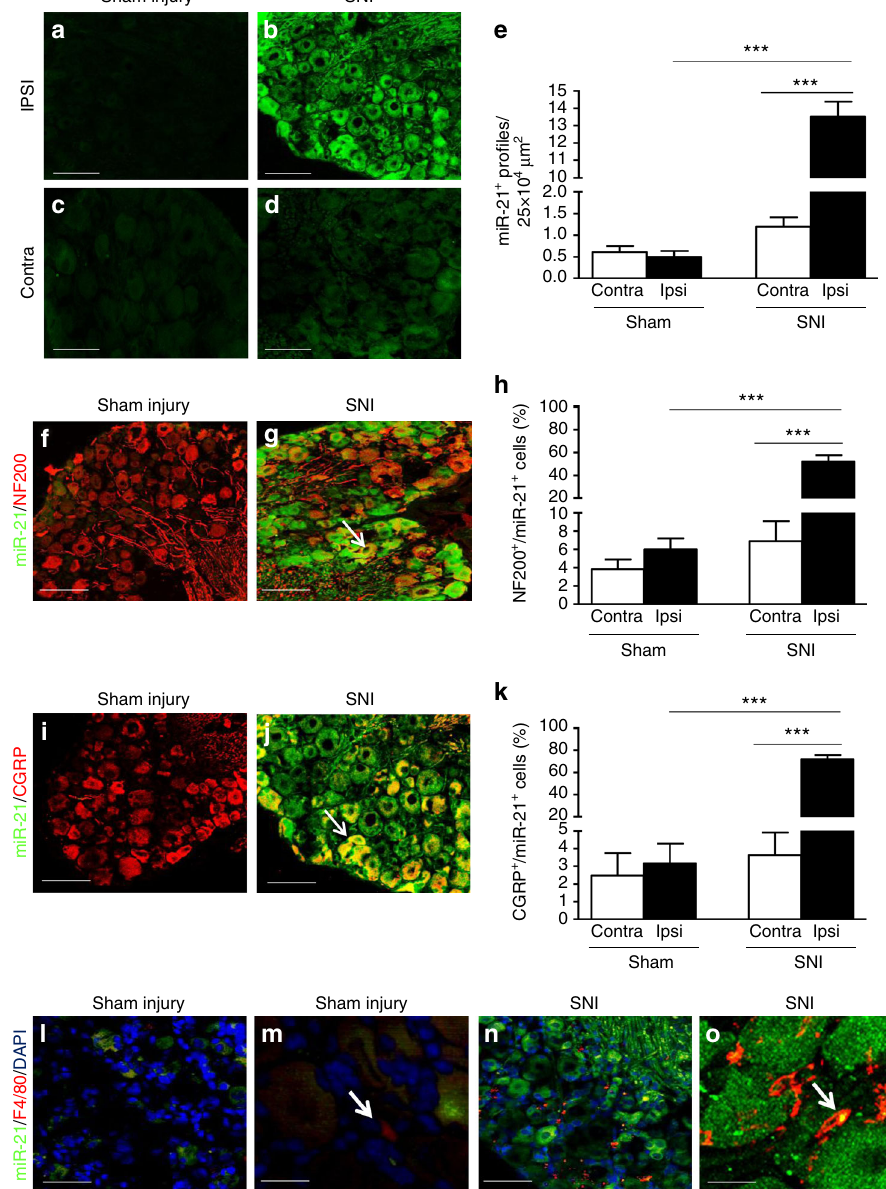
Fig. 1 Expression of miR-21 is increased in DRG neurons following spared nerve injury. a – d Upregulation of miR-21 expression detected by fl uorescence in situ hybridization (FISH) in ipsilateral L5 DRG neurons 7 days after SNI compared to sham injury and contralateral DRG neurons. Scale bar = 100 μ m. e Quanti fi cation of miR-21 + neurons in L4/5 DRG. f , g Immunostaining for large-diameter DRG neurons (NF-200, red) and FISH for miR-21 (green) in sham and SNI ipsilateral L5 DRG. Scale bar = 100 μ m. h Quanti fi cation of large cell bodies NF-200 + neurons that also express miR-21 in L4/5 DRG. i , j Immunostaining of small-diameter DRG neurons (CGRP, red) and FISH for miR-21 (green) in sham and SNI ipsilateral L5 DRG. Scale bar = 100 μ m. k Quanti fi cation of CGRP + neurons that also express miR-21 in L4/5 DRG. l – o Immunostaining of macrophages (F4/80 + cells, red), FISH for miR-21 (green), and nuclei (4',6-diamidino-2-phenylindole (DAPI), blue) in sham and SNI DRG. Scale bar = 100 μ m. m , o Representative example of high-magni fi cation merge (×63), a puncta (yellow) can be seen in macrophages (F4/80 + red cells), scale bar = 10 μ m. Data are means ± S.E.M., n = 3 mice/group. *** P < 0.001, one-way ANOVA, post hoc